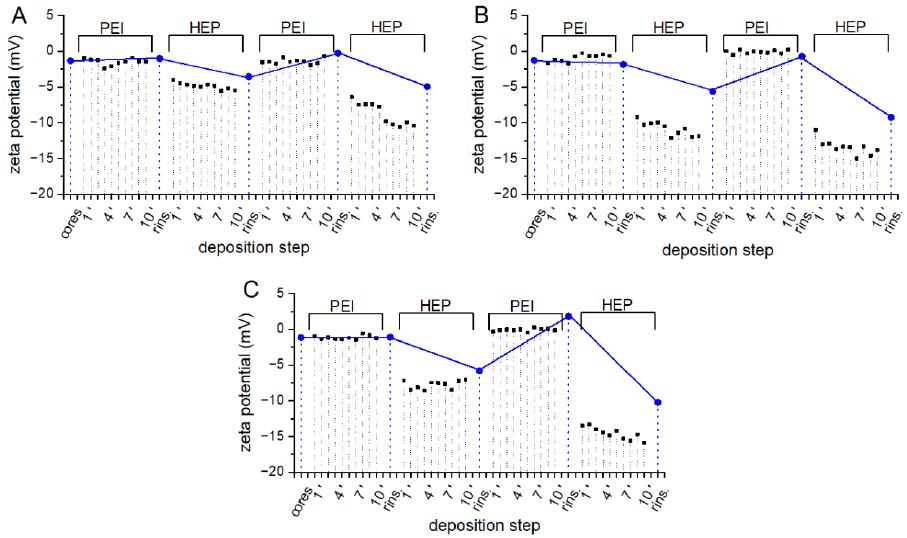
Figure 5. ζ potential changes in the course of PEI/HEP coating deposition in PBS pH 7.4 on ( A ) PCL, ( B ) PLA-co-PCL, and ( C ) PLGA cores. Blue dots represent ζ potential values after deposition of each monolayer and subsequent rinsing, black squares depict in situ changes in ζ potential over 10 min of exposition to polyelectrolyte solution.